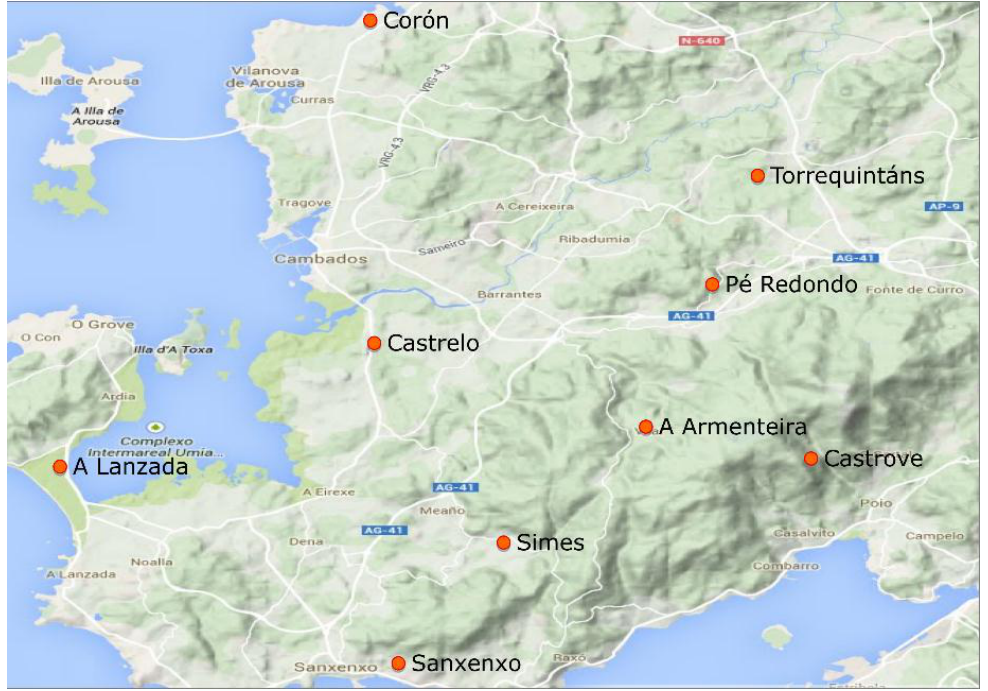
Figure 1. Map of the area